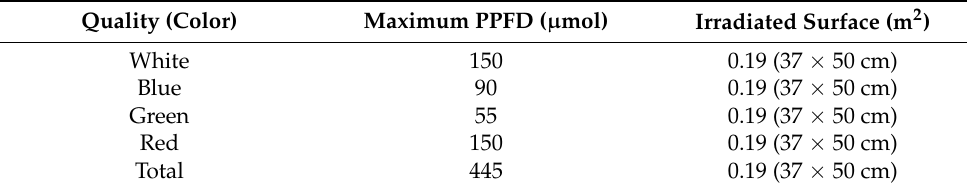
Table 1. Maximum PPFD by quality and irradiated surface.